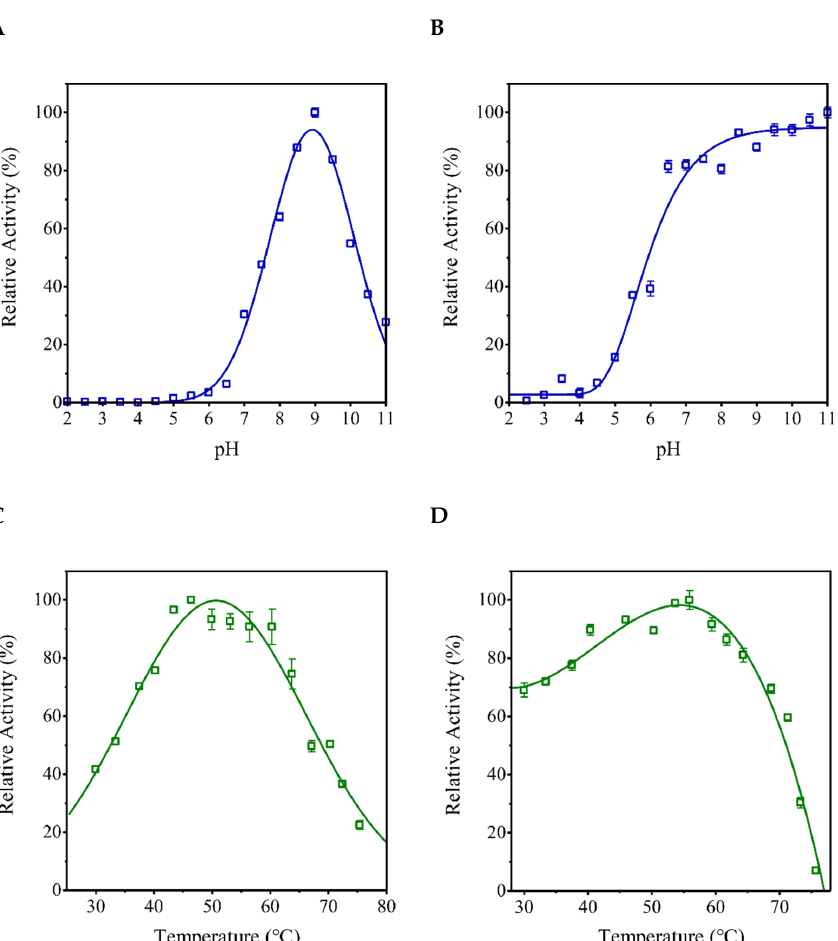
Figure 4. Effects of pH and temperature on activity ( A and C ) and stability ( B and D ) of r Eh HAPp49. Bars represent the standard error (n = 3).